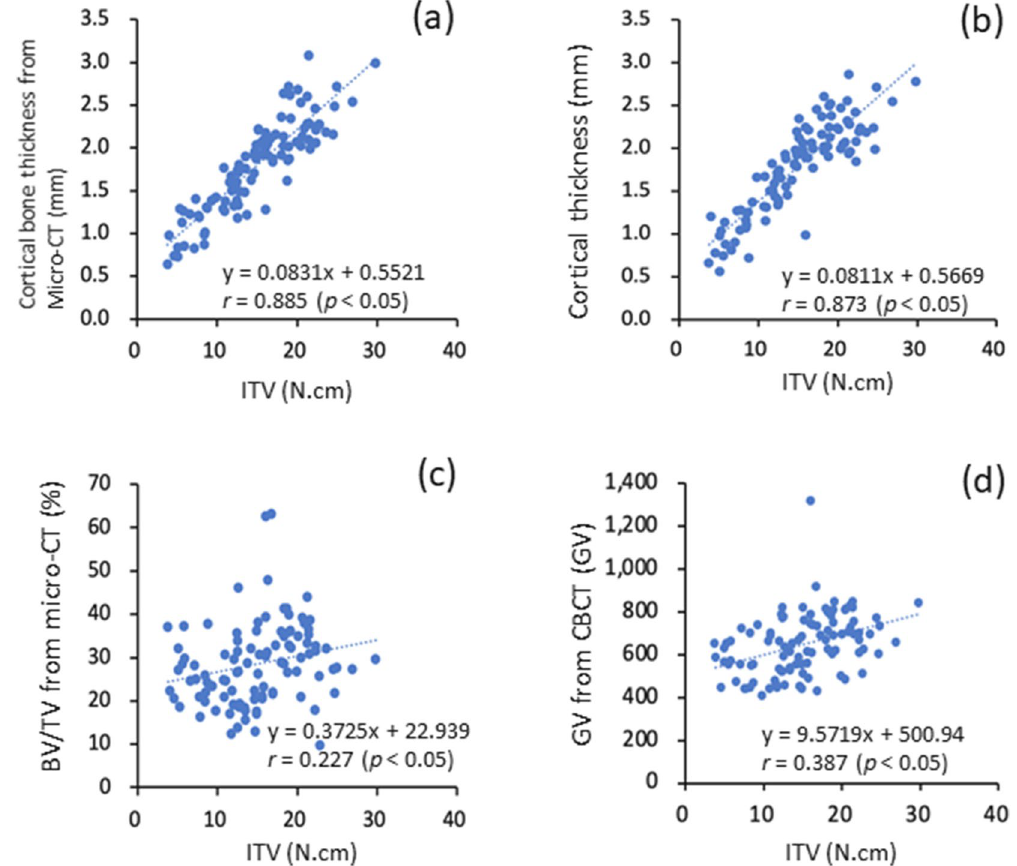
Figure 2. Relationships between ITV and bone quality and quantity parameters: ( a ) cortical bone thickness measured from micro-CT images, ( b ) cortical bone thickness measured from CBCT images, ( c ) BV/TV measured from micro-CT images, and ( d ) GV measured from CBCT